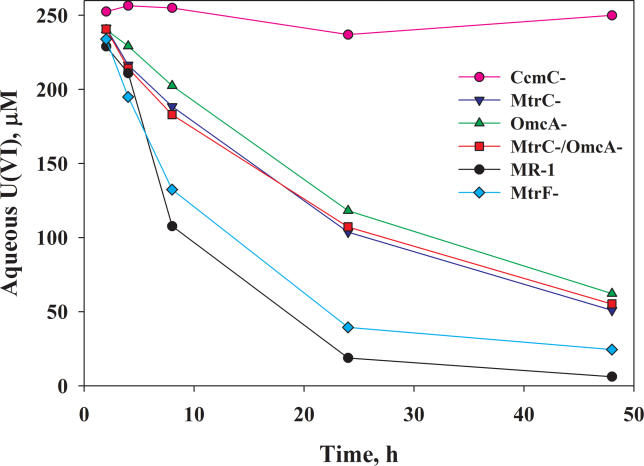
U(VI) Reduction Kinetics by
S. oneidensis MR-1 and Cytochrome Mutant Cells
The reduction of 250 μM U(VI) was determined for MR-1, a mutant lacking all
c-type cytochromes (CcmC
−), single cytochrome deletion mutants (MtrC
−, OmcA
−, or MtrF
−), and a double cytochrome deletion mutant (MtrC
−/OmcA
−). Lines represent the mean data from representative experiments.